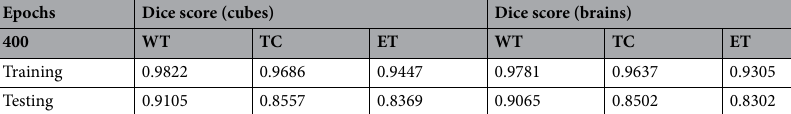
Epochs Dice score (cubes)